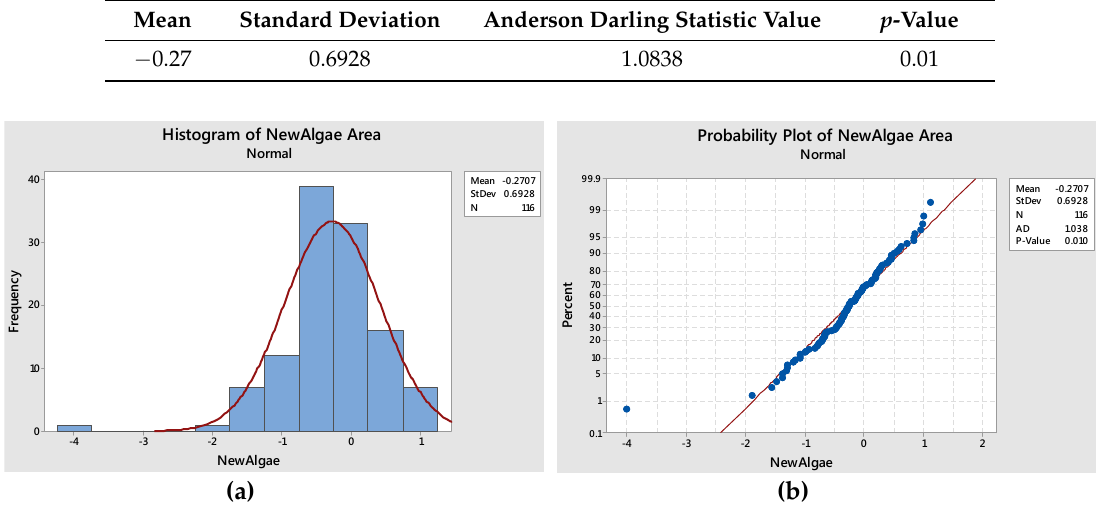
Figure 4. ( a ) Histogram of new Algae area. ( b ) Probability plot of new Algae area.